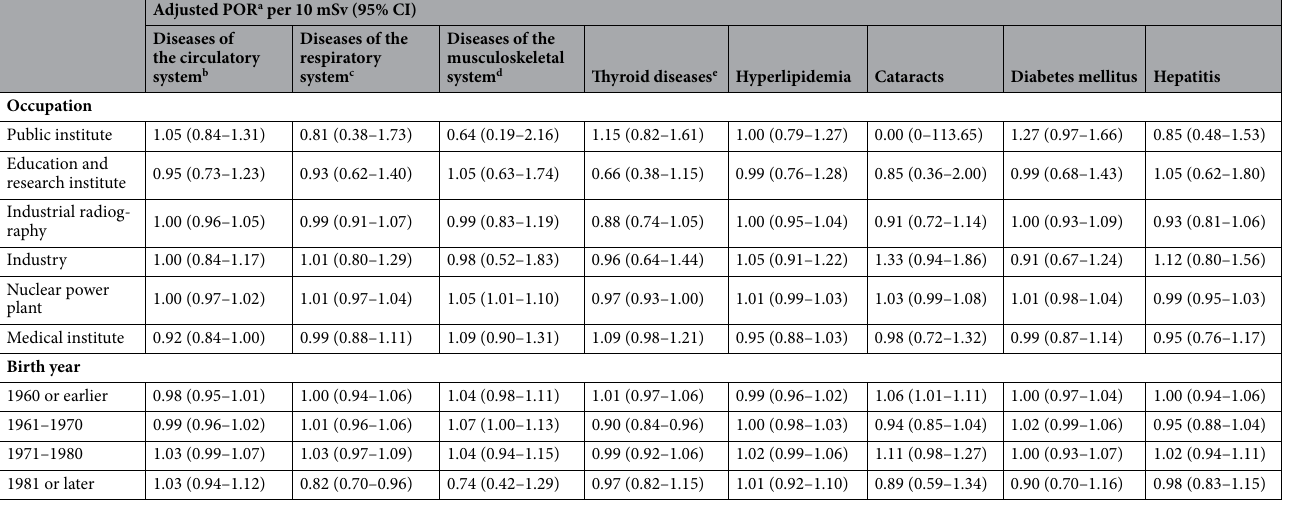
Table 3. Prevalence odds ratios (PORs) per 10 mSv according to occupation and birth year. CI confidence interval. a Prevalence odds ratios were adjusted for sex, age, occupation, duration of employment, smoking status, alcohol status, regular exercise, body mass index, and night-shift work. b Including hypertension, stroke, myocardial infarction, and angina. c Including pulmonary tuberculosis and asthma. d Including rheumatoid arthritis and osteoporosis. e Including benign thyroid tumor, thyroid nodule, thyroid goiter, thyroiditis, hyperthyroidism, and